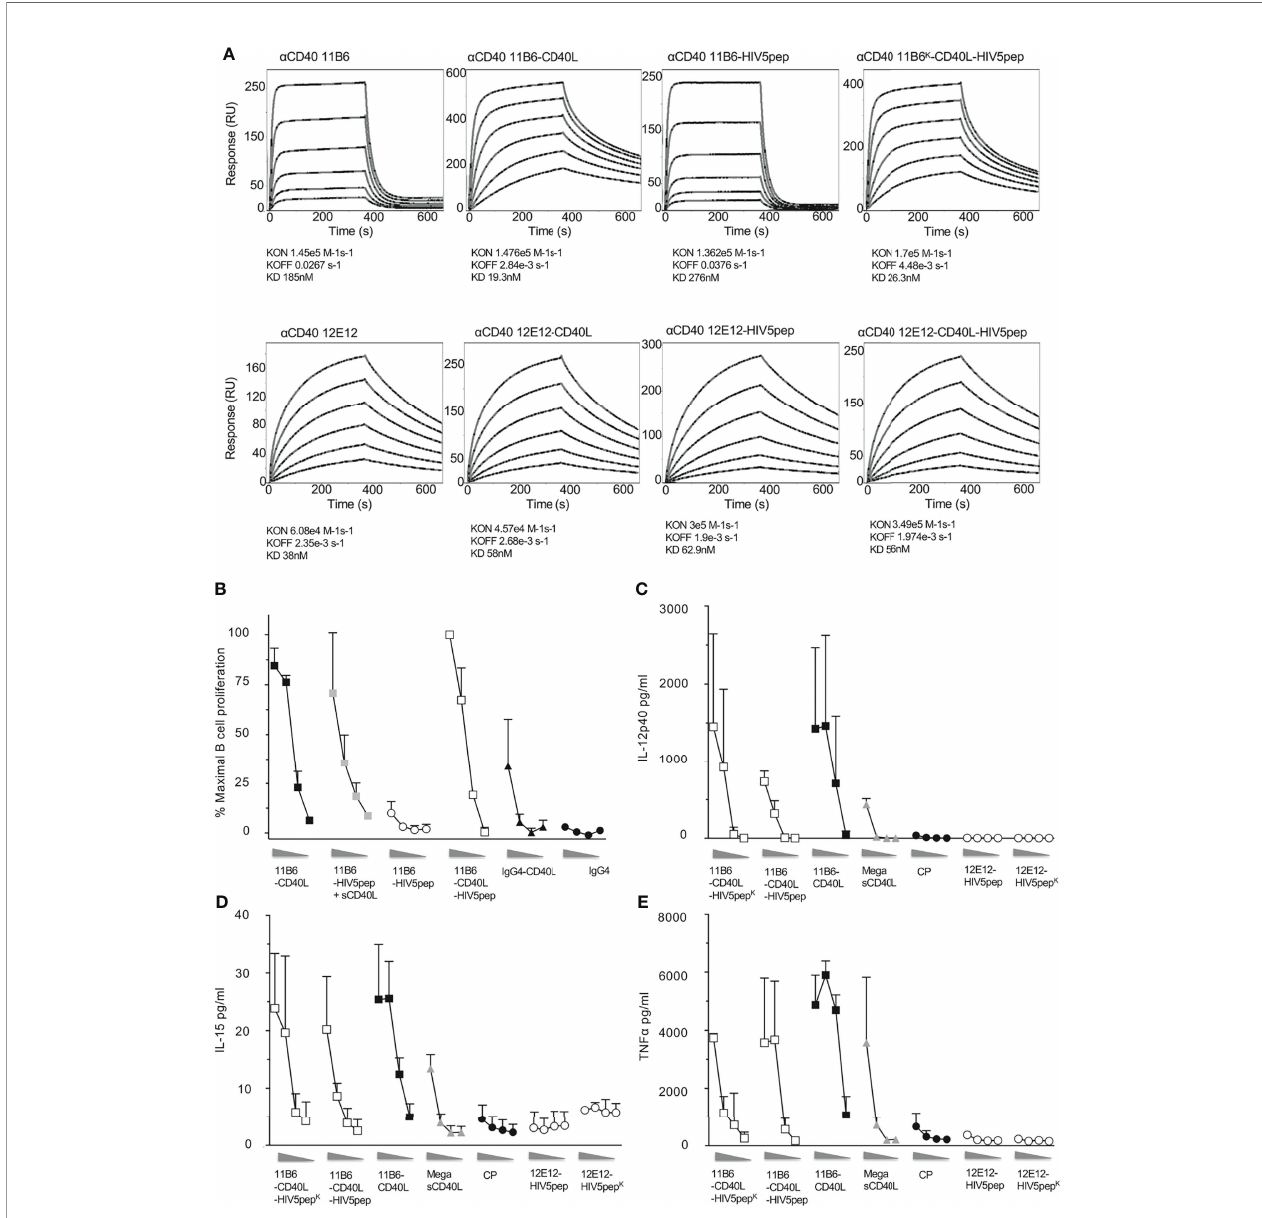
FIGURE 2 | Direct fusion of CD40L to anti-CD40 antibody-antigen fusion protein improves af fi nity for CD40 binding and confers high agonist activity on human B cells and MDDCs. (A) Shows surface plasmon resonance analyses for anti-CD40 11B6 (top panels) and anti-CD40 12E12 (bottom panels), with or without directly fused CD40L and/or with or without the HIV5pep adduct. (B) Shows B cell proliferation in response to a dose range (left to right, 10, 1, 0.1, 0.01 nM) of the indicated anti- CD40 11B6 hIgG4 antibodies or antibody-HIV5pep fusions with added 60 nM sCD40L, or with CD40L directly fused to the antibody L chain C-termini. Data represent averaged values for two donors each normalized for maximum proliferation. (C – E) Shows DC activation to a dose range (left to right, 10, 1, 0.1, 0.01 nM) of each indicated IgG4 mAb or Mega sCD40L (a trimeric form of sCD40L, EnzoLifeScience, ref ALX-522-110-C010) based on the extent of cytokine secretion determined at 24 h. The results presented are averaged data over three experiments using two different donors. Panels (C – E) show, respectively, the averaged IL-12 p40, TNF a , and IL-15 secretion. The error bars are standard deviation of the mean. Supplemental Table 1 summarizes the relative ef fi cacies of this cytokine secretion